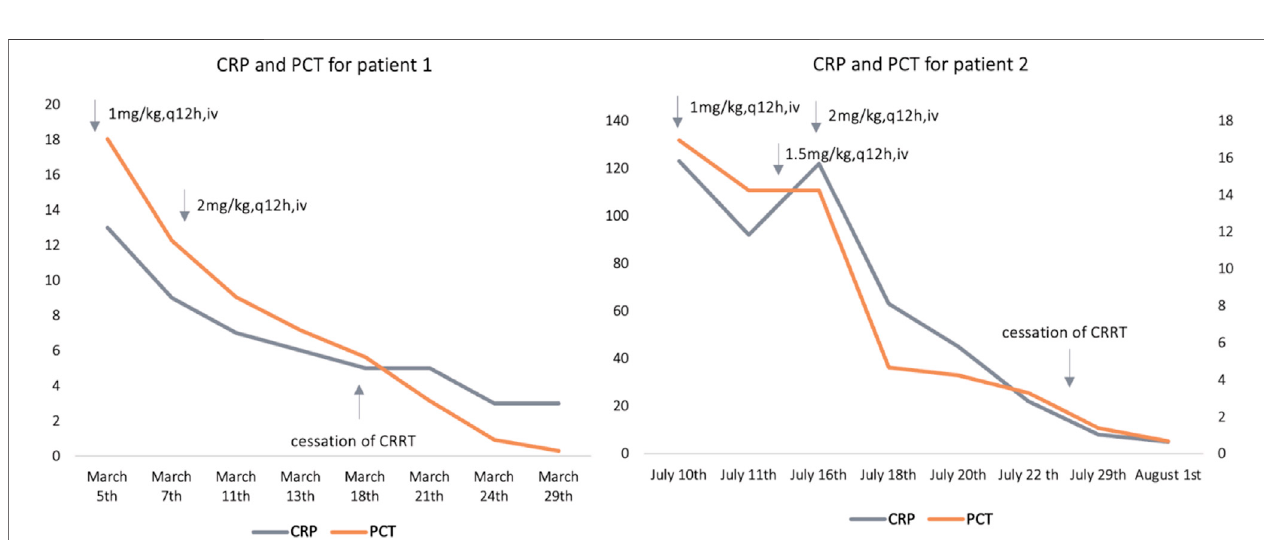
FIGURE1| Polymyxin Bdoseregimenswiththeconcomitantdrugsand estimatedC-reactiveprotein (CRP),and procalcitonin(PCT) levelsatdifferenttime points; for patient 1, cessation of CRRT (continuous renal replacement) was on 18 th March; for patient 2, cessation of CRRT was on 25 th July. CRP: C-reactive protein (mg/L), PCT: procalcitonin